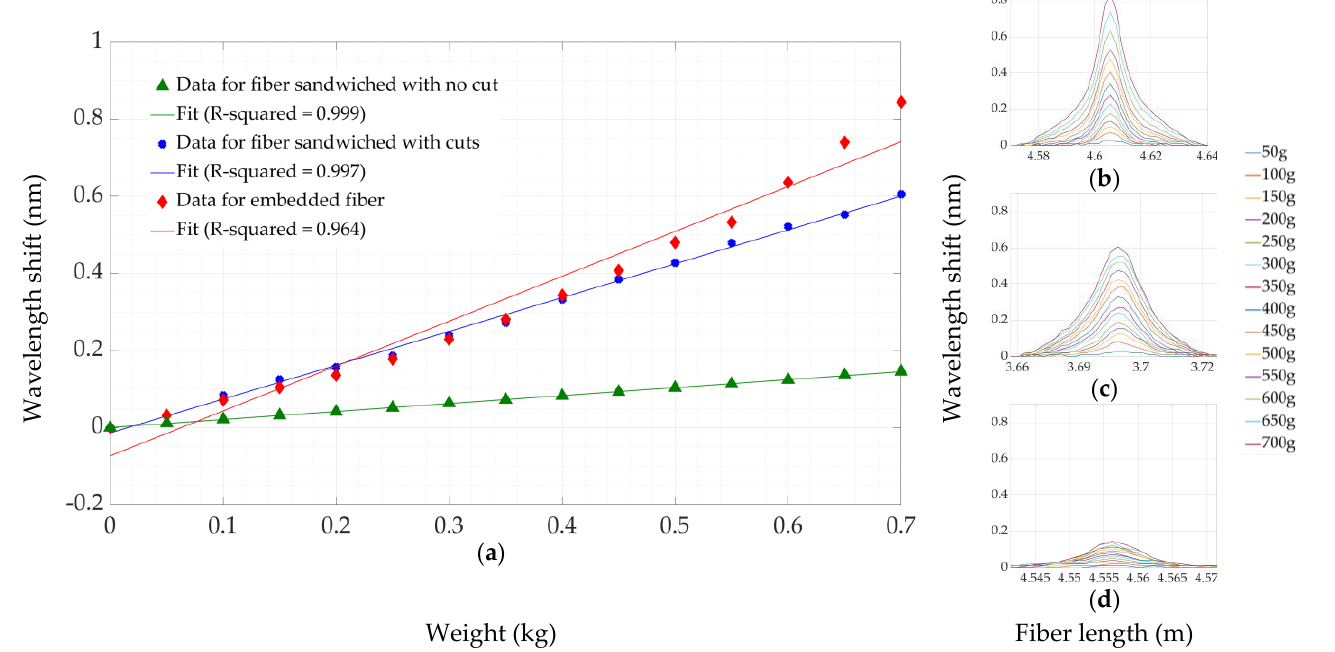
Figure 7. Peak wavelengths shift over applied weight (pressure sensitivity) of the three described fiber fixation methods ( a ). Wavelength shift distributed over the fiber in case of “embedded fiber” ( b ), “sandwiched fiber with cuts” ( c ), “sandwiched fiber without cuts” ( d ).